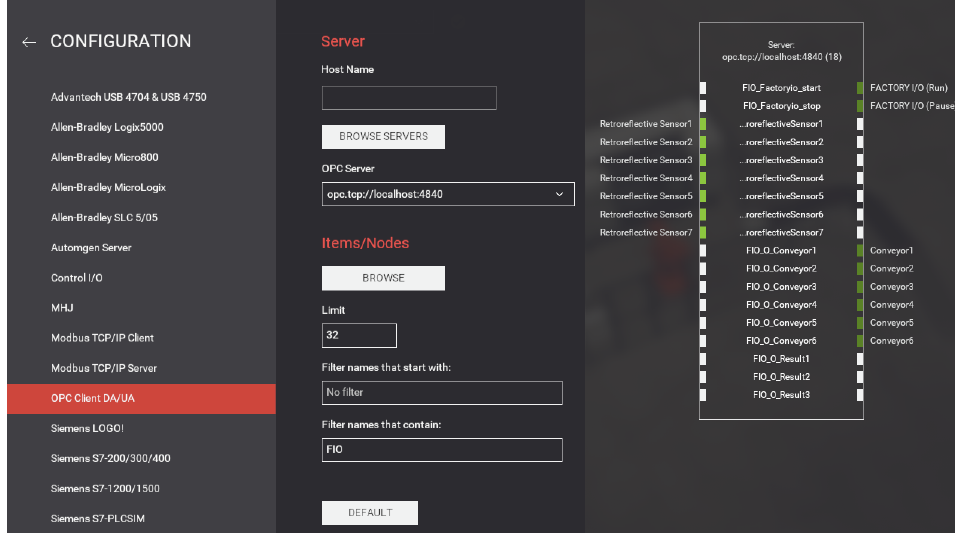
Figure 20. OPC UA Client Factory